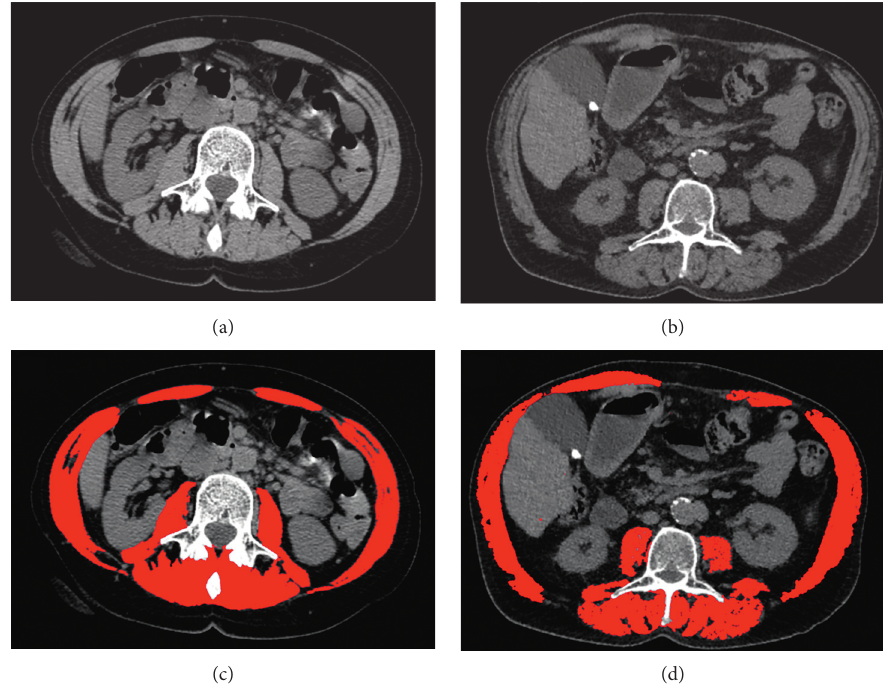
Figure 2: Computed tomography images of two different patients, one without cirrhosis (a) and one with cirrhosis (b). The patient without cirrhosis does not demonstrate imaging sign of sarcopenia using the public domain software (ImageJ) (c). The patient with cirrhosis demonstrates imaging sign of sarcopenia using the public domain software (ImageJ)